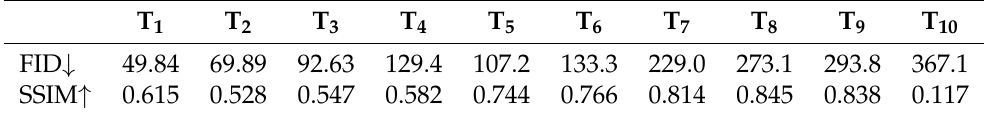
Figure 4. Reference and tampered MRI images. Table 1. Reference metrics values for transformations: T 1 —H-flip, T 2 —H-offset, T 3 —zoom in, T 4